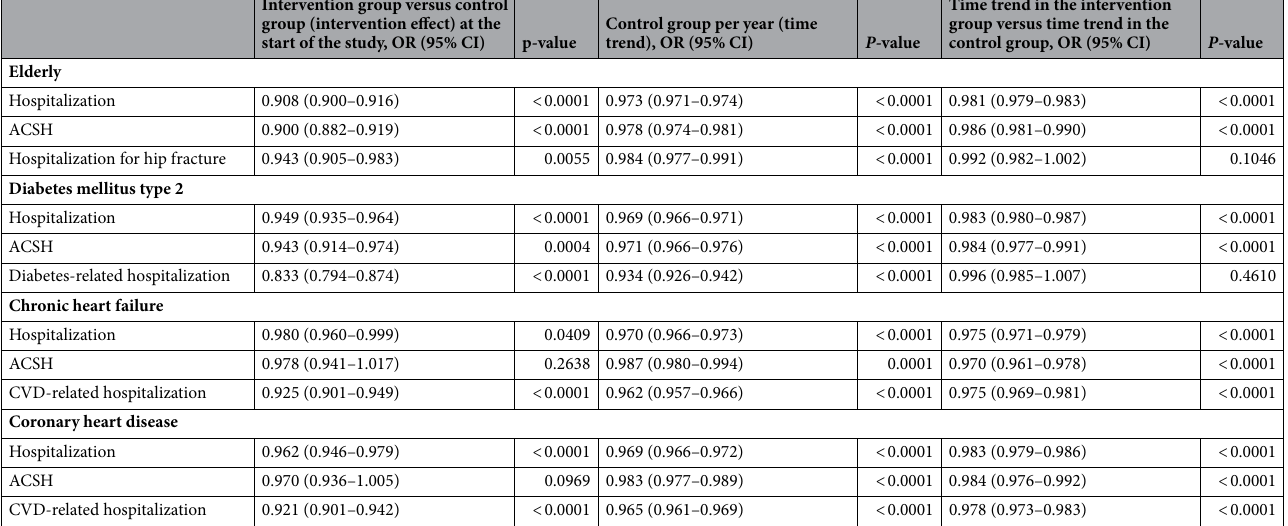
Table 3. Hospitalization per year and patient: Odds ratios* based on the longitudinal analysis (2011–2018). P -values relate to adjusted effect estimates in generalized linear models based on a longitudinal analysis from